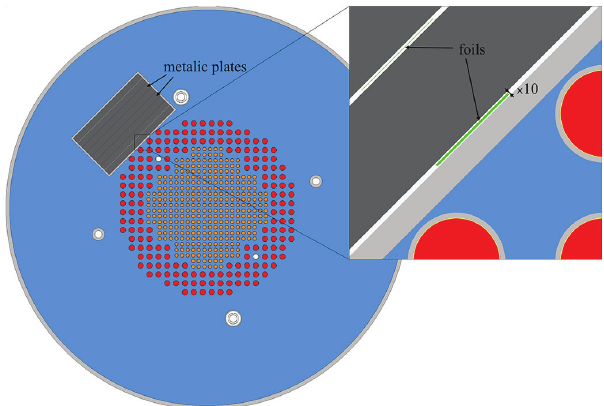
Fig. 2. Axial section of CROCUS represented using the Ser- pent2 code, with the addition of the PETALE metal reflector (top-left). The oxide uranium fuel is displayed in orange, the metal uranium fuel in red, and the water in blue. The four cir- cles in the water reflector are fission and ionisation chambers used as CROCUS monitors. A zoom on the interface between CROCUS and the metal reflector shows the first foil with a width multiplied by 10 in order to be visible (1g of indium for the first foil instead of 0.1g).